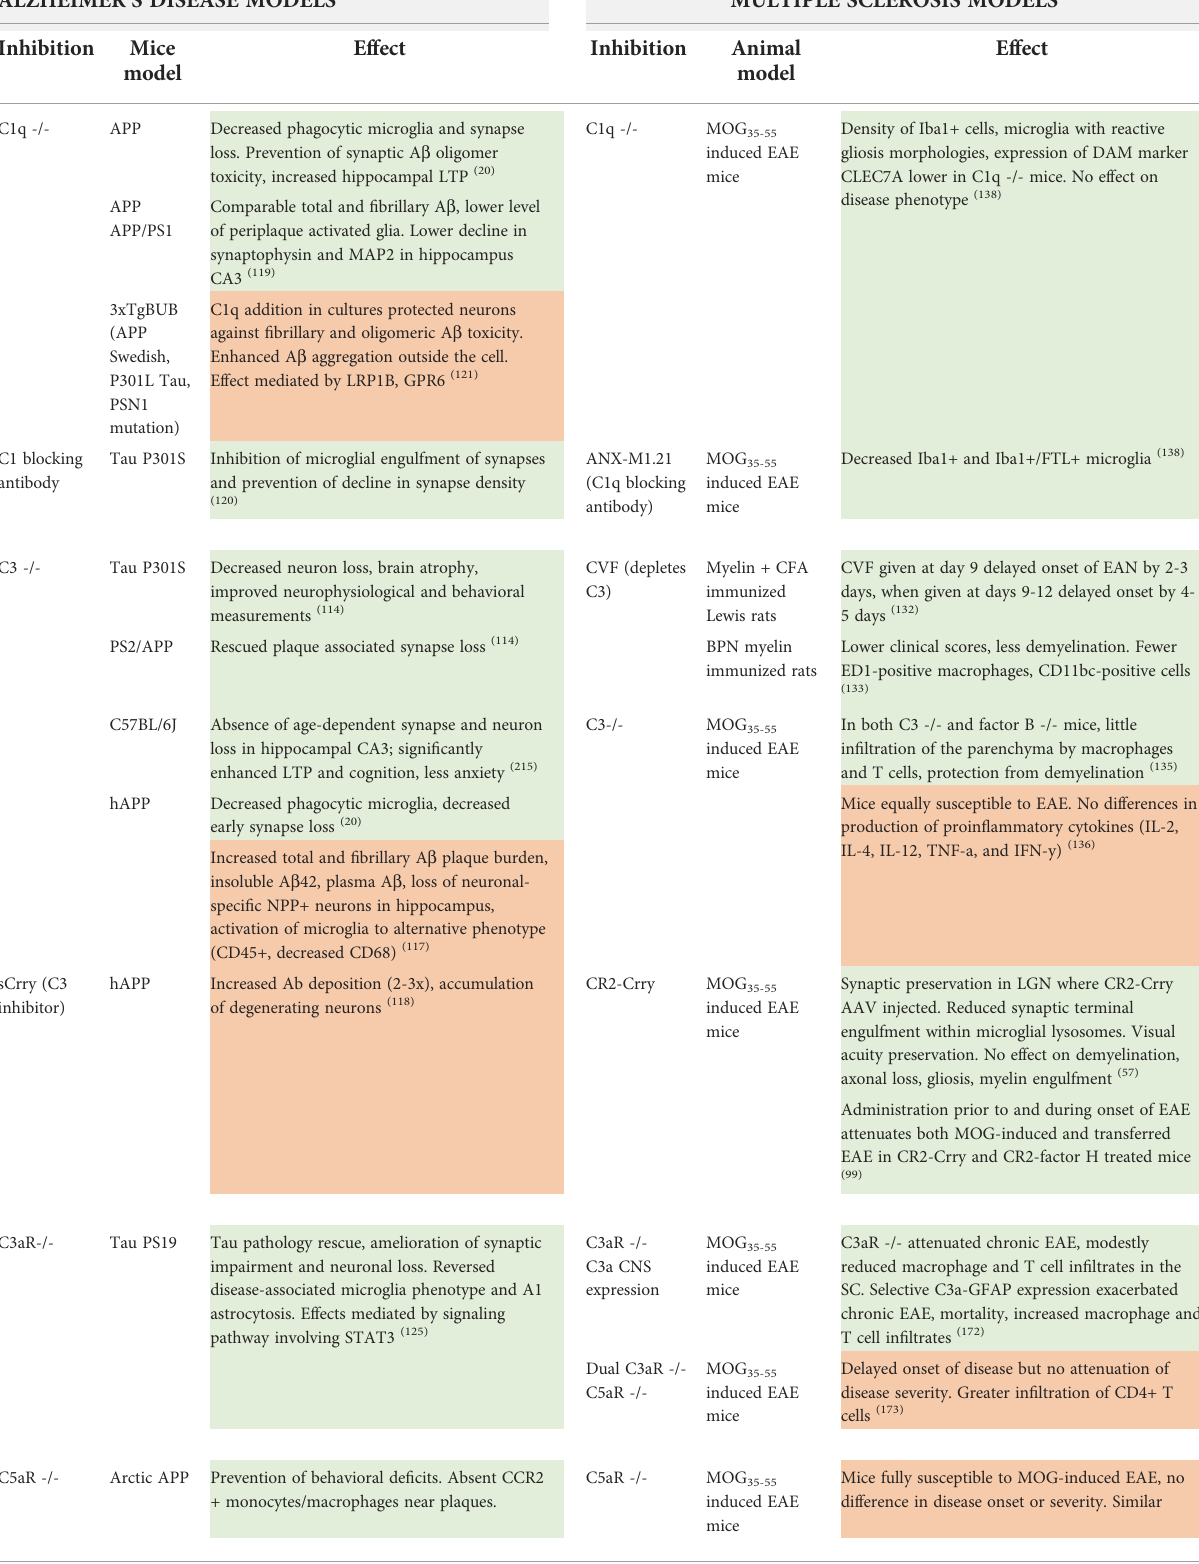
TABLE 1 Descriptive comparison of the effects of complement inhibition in AD and MS animal